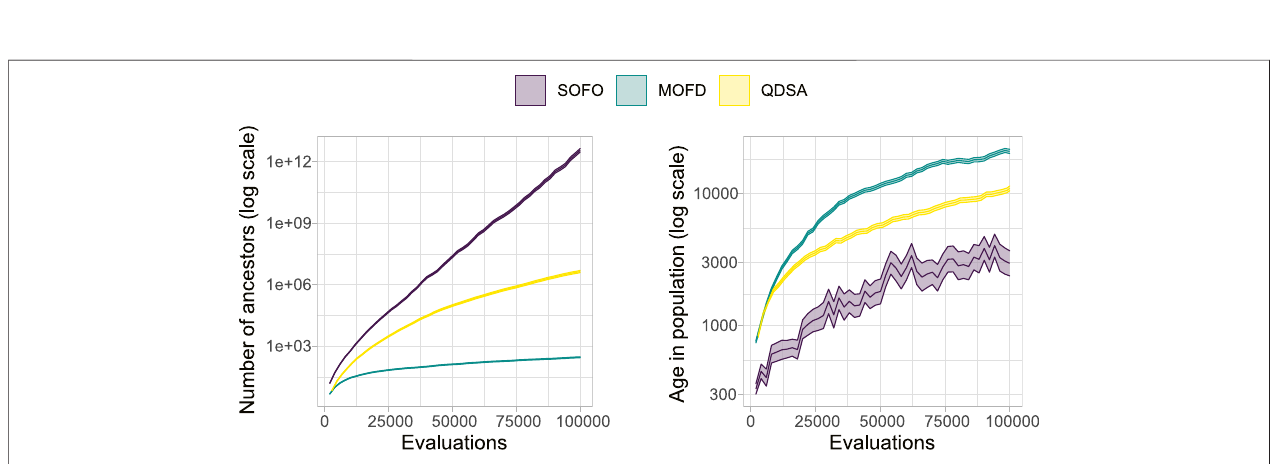
FIGURE11| Genealogicalancestryattributes.Onthelefttheaveragenumberofancestorsforeachsolutioninthepopulationisshown.Ontherighttheageofeach solution is shown, where age is number of evaluations since the solution fi rst appeared in the population. The colored area represents the 95% con fi dence interval.